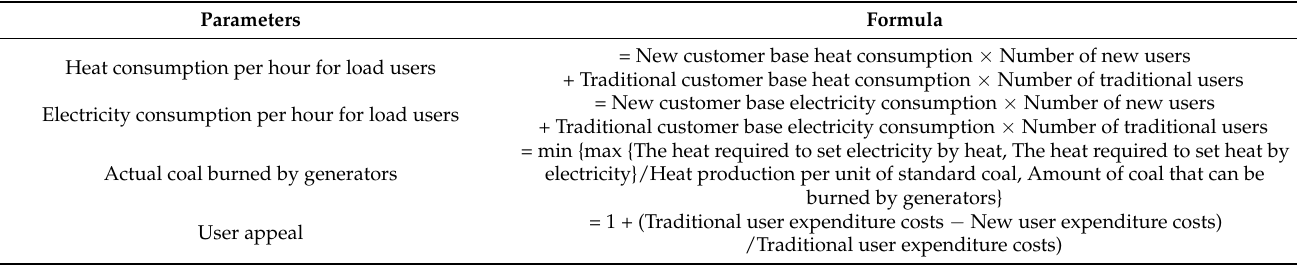
Figure 4. Diffusion stock flow diagram for the cold-heat-electricity multi-energy package. Table 1. Mathematical model for the diffusion of cold-heat-electric multi-energy packages.